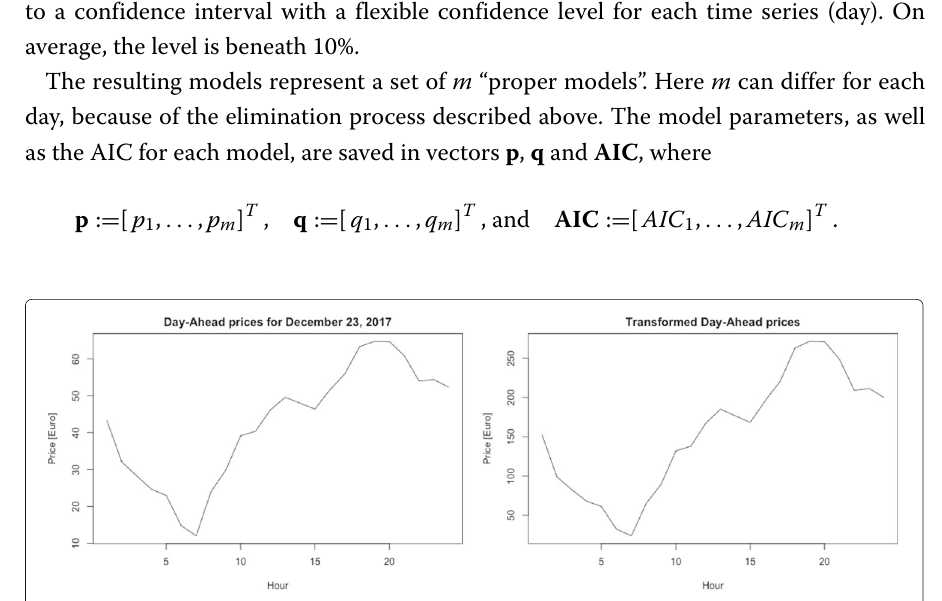
normal shape. Since the logarithm is applied to the data, the new values differ greatly from the original ones in magnitude.